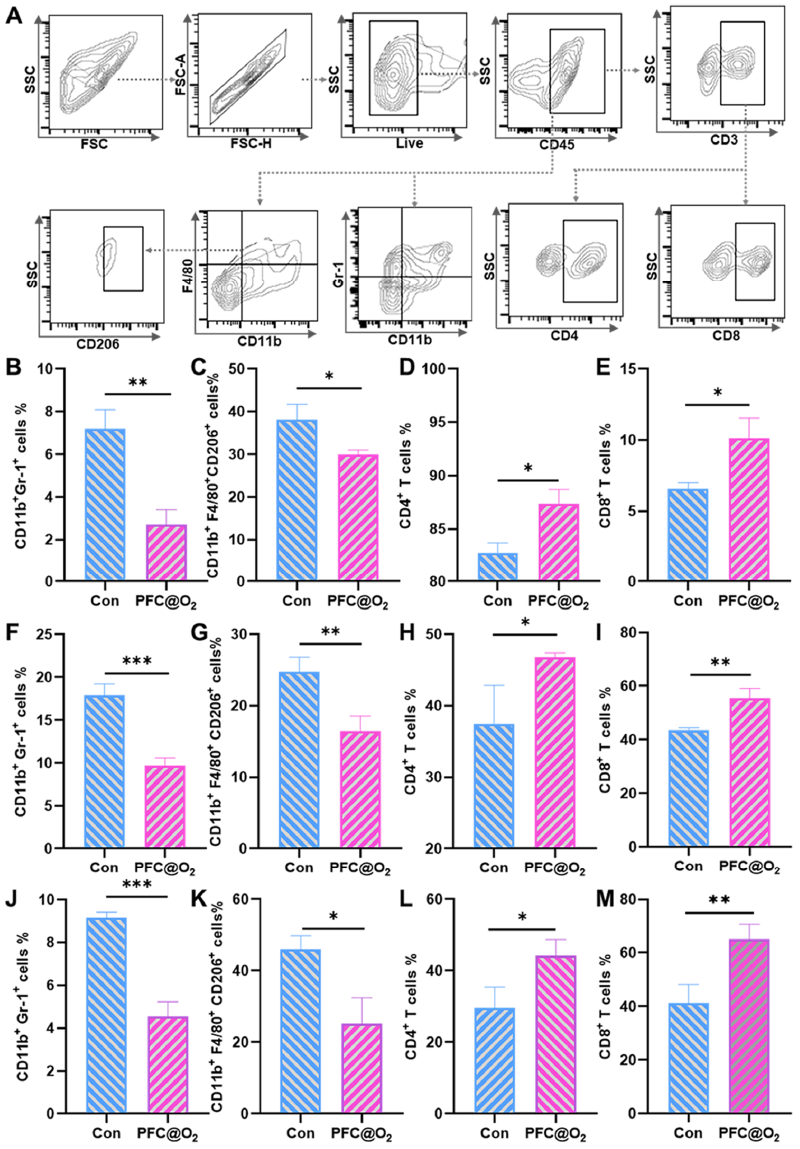
Figure 4. PFC@O 2 reversed the immunosuppressed TME. ( A ) A schematic gating strategy of immune cells in a 4NQO-induced mouse OSCC model. Flow cytometric quantification of ( B – E ): the ratio of CD11b + Gr-1 + MDSCs, CD11b + F4/80 + CD206 + M2-like macrophages, CD4 + , and CD8 + T cells in the OSCC TME of mice. ( F – I ) The ratio of CD11b + Gr-1 + MDSCs, CD11b + F4/80 + CD206 + M2-like macrophages, CD4+, and CD8+ T cells in the spleen of mice. ( J – M ) The ratio of CD11b + Gr-1 + MDSCs, CD11b + F4/80 + CD206 + M2-like macrophages, CD4 + , and CD8 + T cells in the lymph nodes of mice. n = 3 per group. (* p < 0.05, ** p < 0.01, and *** p < 0.001). 3.5. The Expression of HIF-1α and CA IX were Positively Correlated with the Ratio of CD68 + /CD163 + Macrophages Infiltrated in Human OSCC Based on the findings of the above in vitro and animal experiments, we collected 55 clinical samples of OSCC after obtaining the approval of the Medical Ethics Committee of